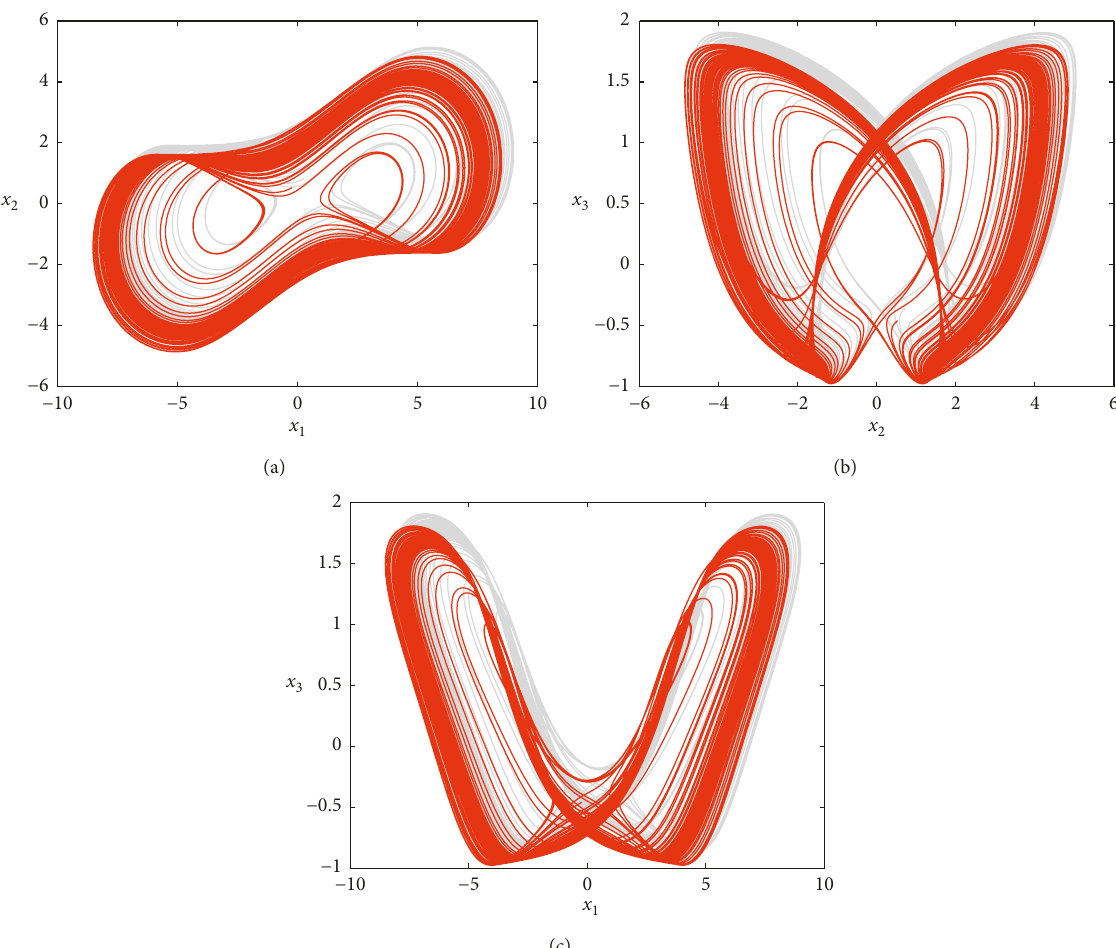
Figure 2: Chaotic phase diagrams of the proposed